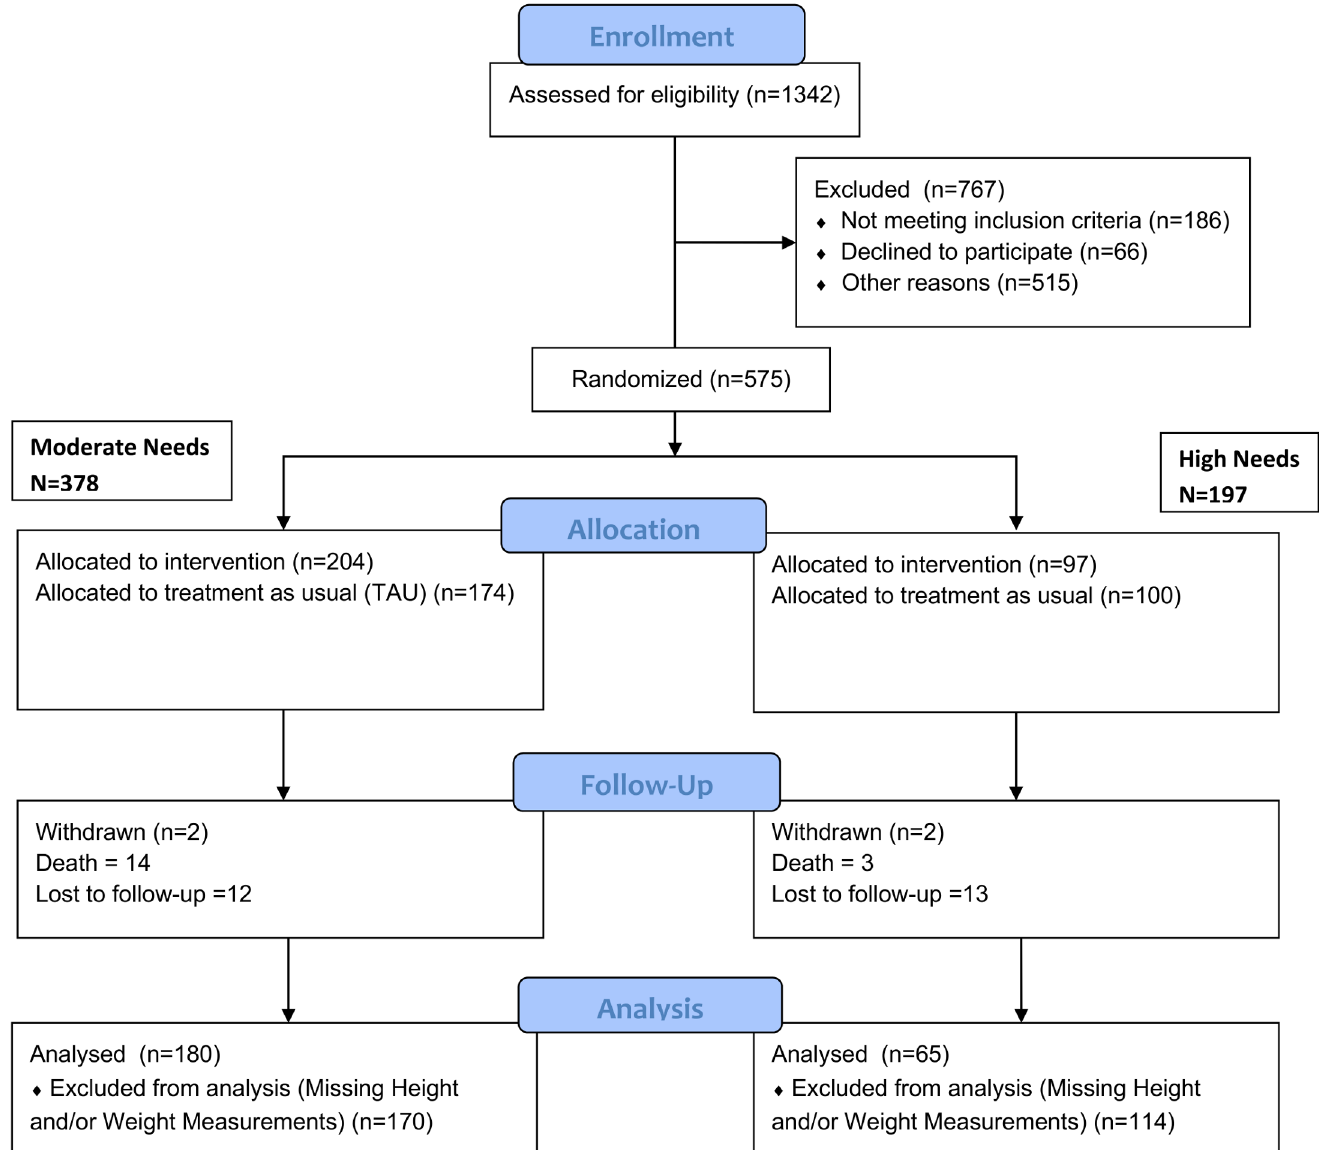
Fig 1. CONSORT Diagram. This figure displays the random assignment of participants to intervention and control groups based on need level and indicates the number of individuals who had data for inclusion in this particular study.